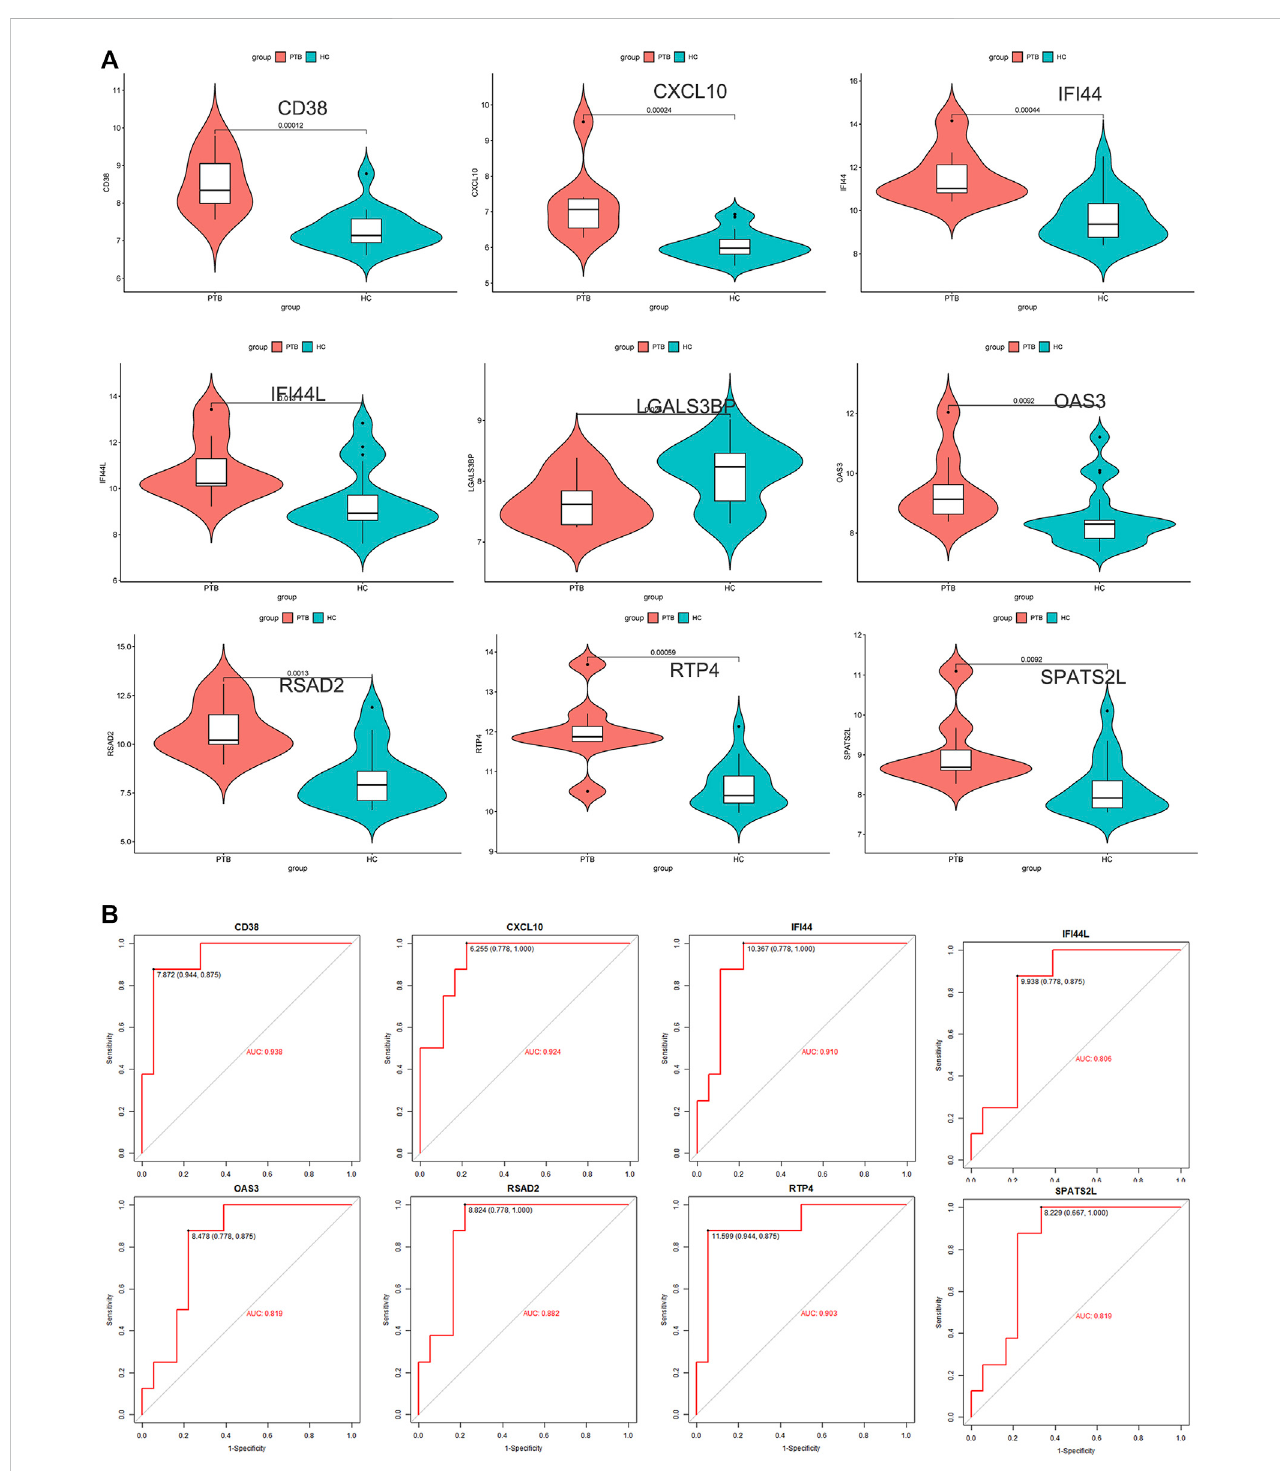
FIGURE 5 External validation. (A) Expression level of 9 candidate key genes between normal and TB samples were veri fi ed using external dataset (GSE34608). (B) ROC curve analyses for SPATS2L, RTP4, RSAD2, OAS3, IFI44L, IFI44, CXCL10, and